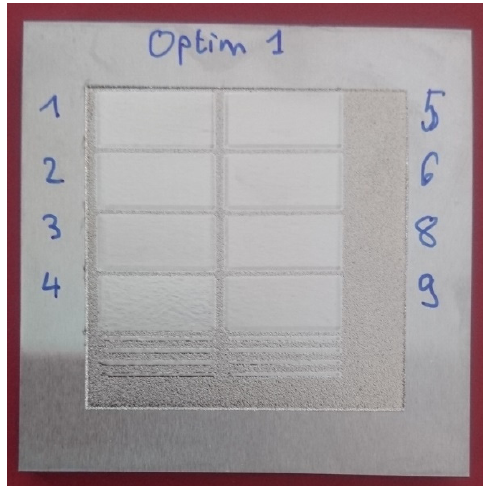
Figure 10. Pictures of the DoE optimization surfaces after LP with parameters as shown in Table 4 (Optim 7 is the same as DoE 12 and is not repeated here). Below the surfaces are also single lines with the same laser parameters without overlap.